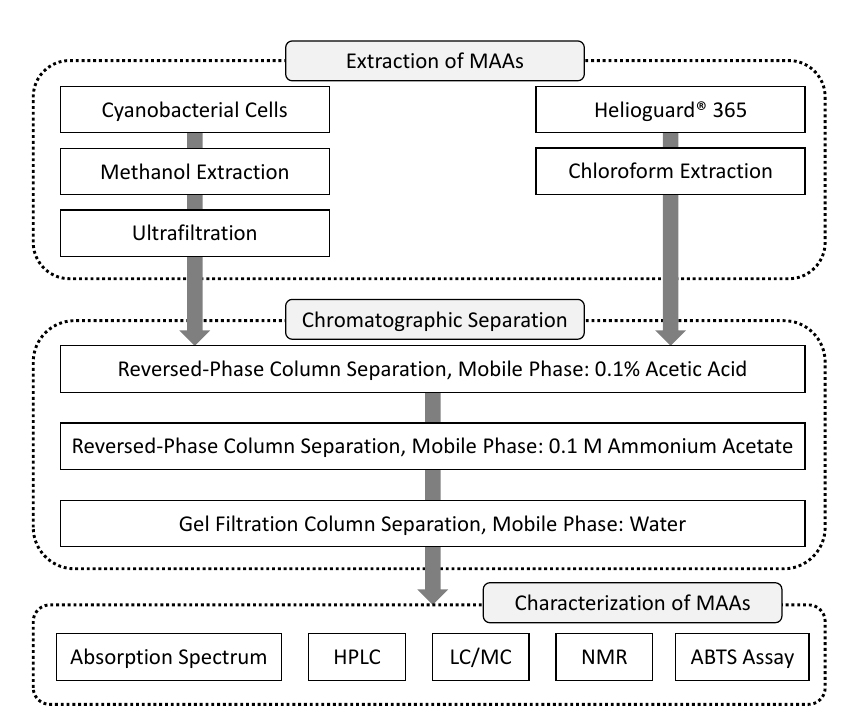
Figure 1. Stages of the isolation and characterization of mycosporine-like amino acids (MAAs).